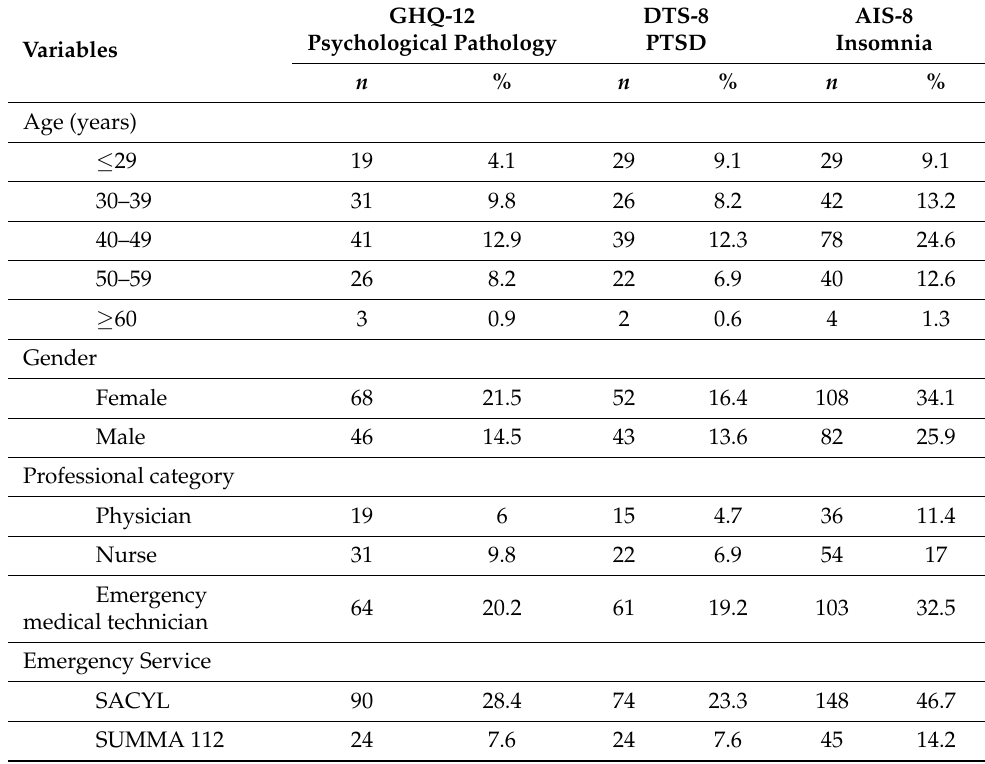
Table 2. Sociodemographic distribution of polytomous variables according to the results of GHQ- 12: suspected psychological pathology (GHQ-12 = 5–6), DTS-8: suspicion of post-traumatic stress disorder (DTS-8 ≥ 12), and AIS-8: insomnia (AIS-8 ≥ 6) ( n =